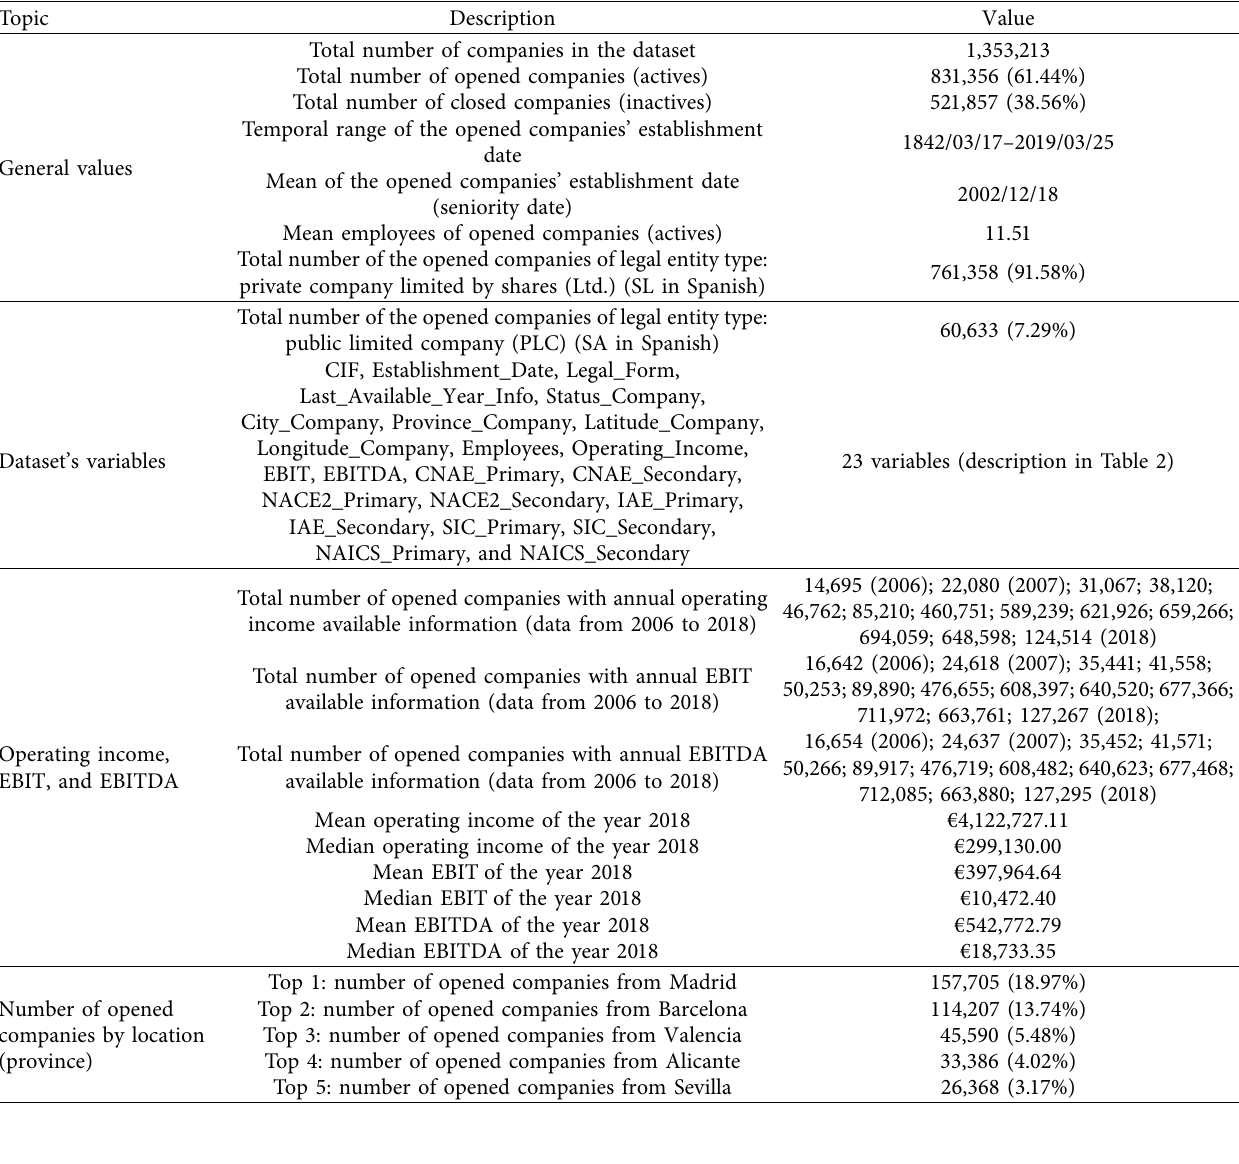
Table 4: Quantitative description of the company dataset.